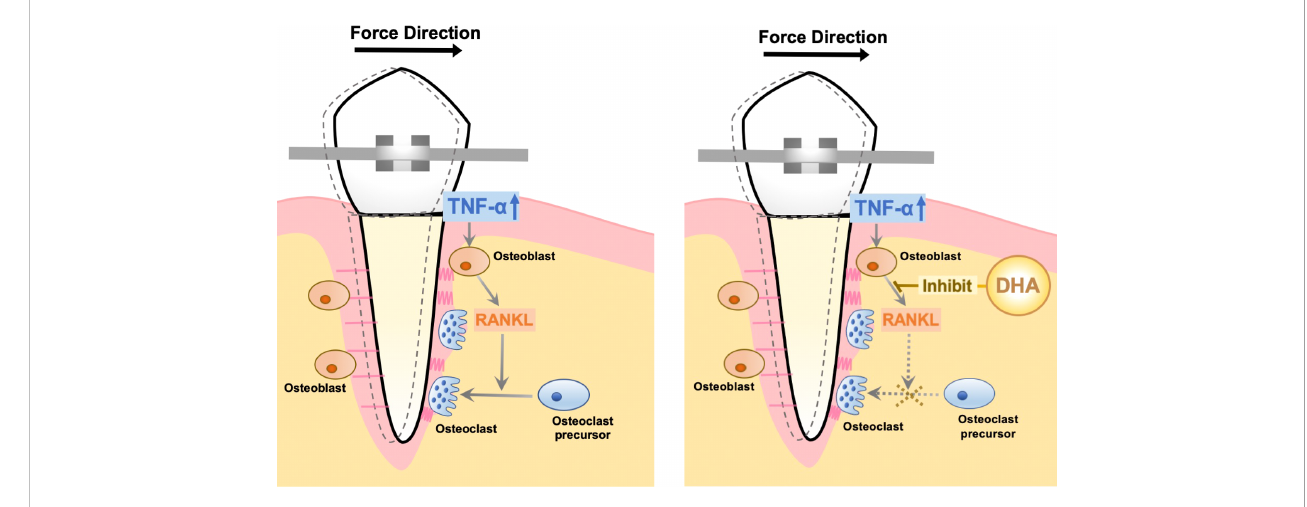
FIGURE 7 Schema of the mechanism of DHA-inhibited osteoclast formation during